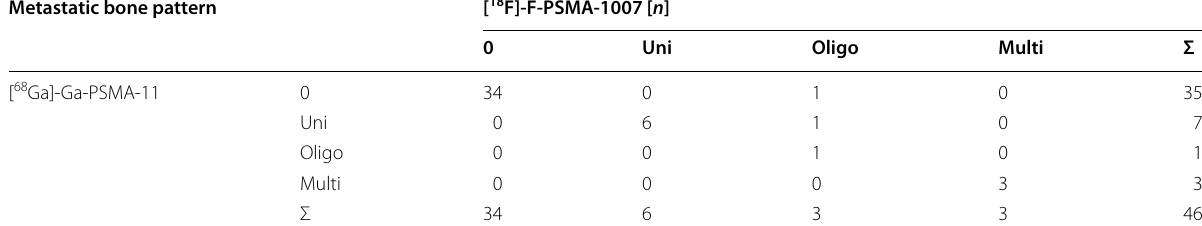
Table 7 Bone metastatic pattern by tracer Metastatic bone pattern